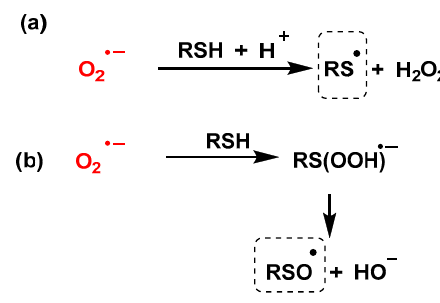
Figure 50. Two pathways for the reaction of O 2•– with thiols.